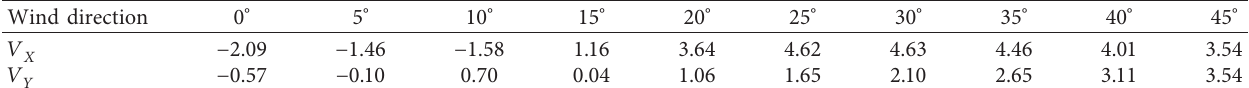
11 on the L-3 model with wind direction (m/s).